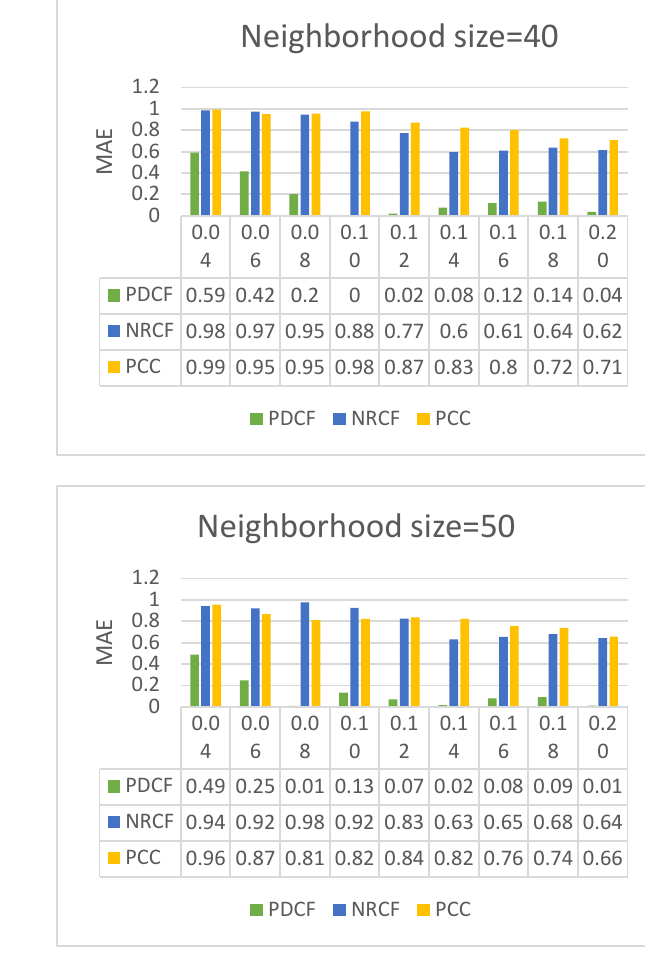
Figure 8. Performance comparison between the PDCF, NRCF and PCC under various densities and neighborhood